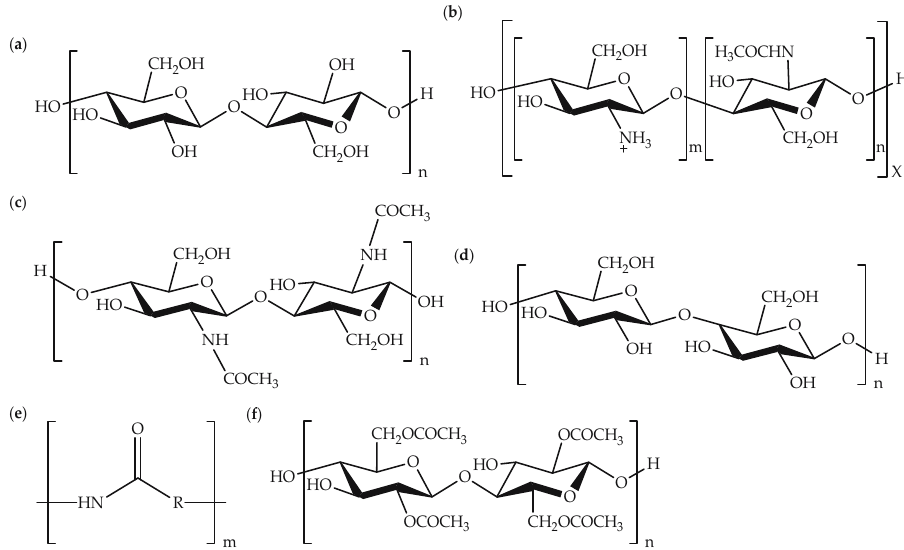
Figure 3: Chemical structures of biopolymers: ( a ) cellulose, ( b ) chitosan, ( c ) chitin, ( d ) starch, ( e ) zein protein, and ( f ) cellulose acetate.